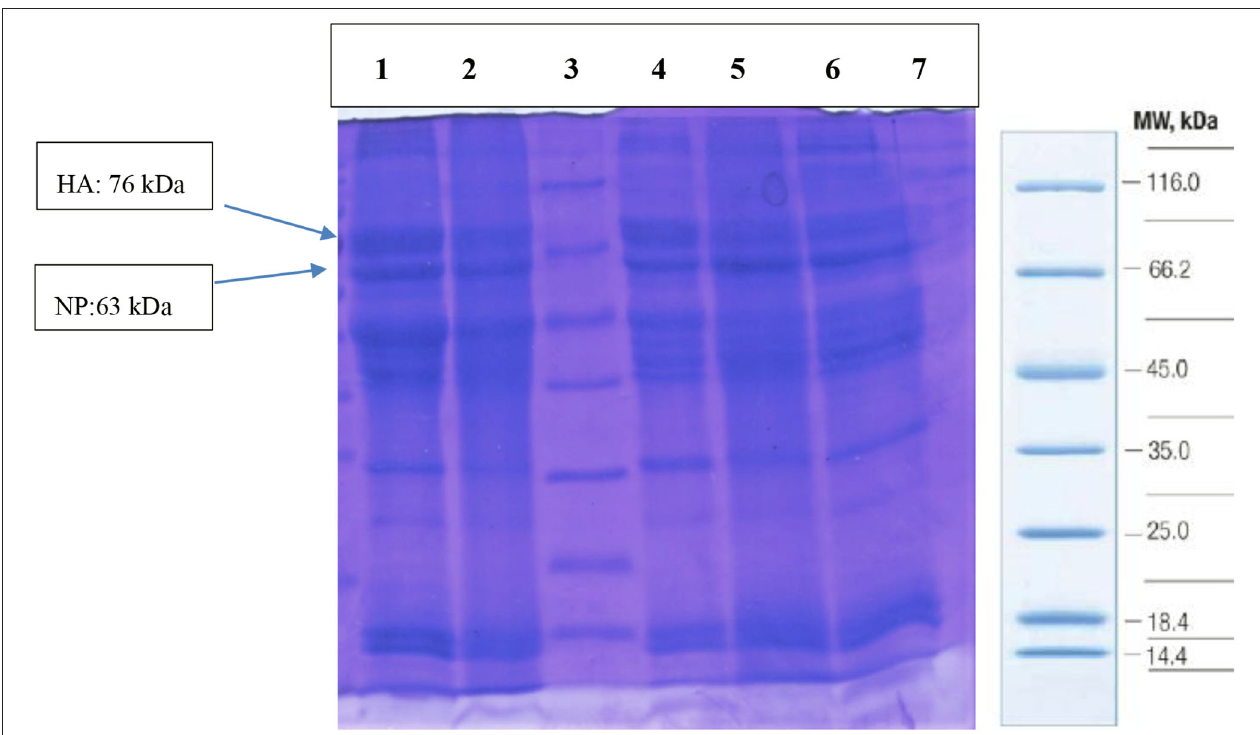
FIGURE 2 | The quality of viral protein by SDS-PAGE in irradiated (Lanes: 4, 5, 6) and non-irradiated (Lanes: 1, 2) LPAIV-H9N2 samples. Lane 3: protein markers (Cat No: SM0431), HA, Hemagglutinin antigen; NP,